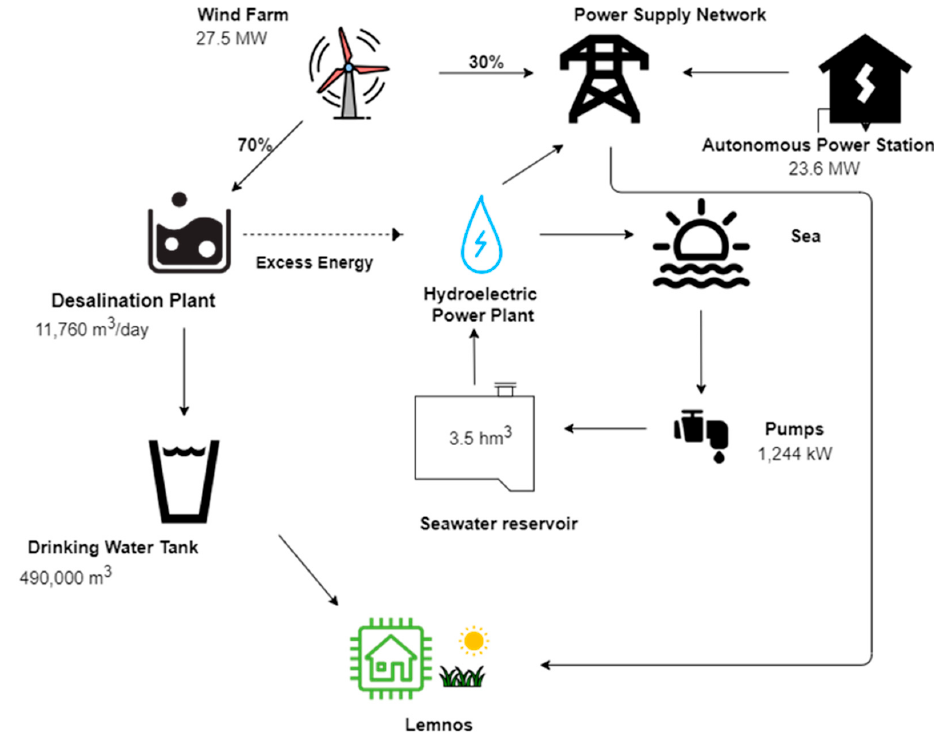
Figure 8. Schematic representation of operating scenario 1.